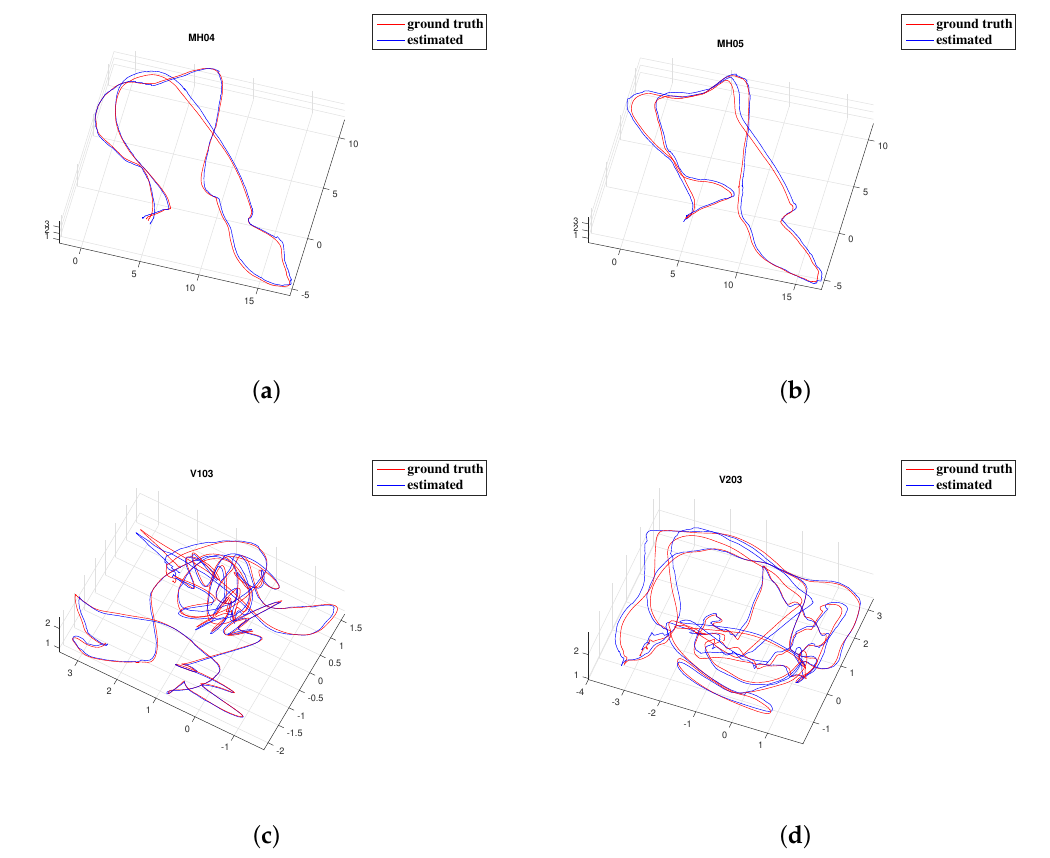
Figure 5. Results of 4 EuRoC sequences classified as “difficult”. Estimated trajectories are aligned with ground truths by a 6-DOF Sim ( 3 ) transformation (without scale). ( a ) MH_04_difficult. ( b ) MH_05_difficult. ( c ) V1_03_difficult. ( d )